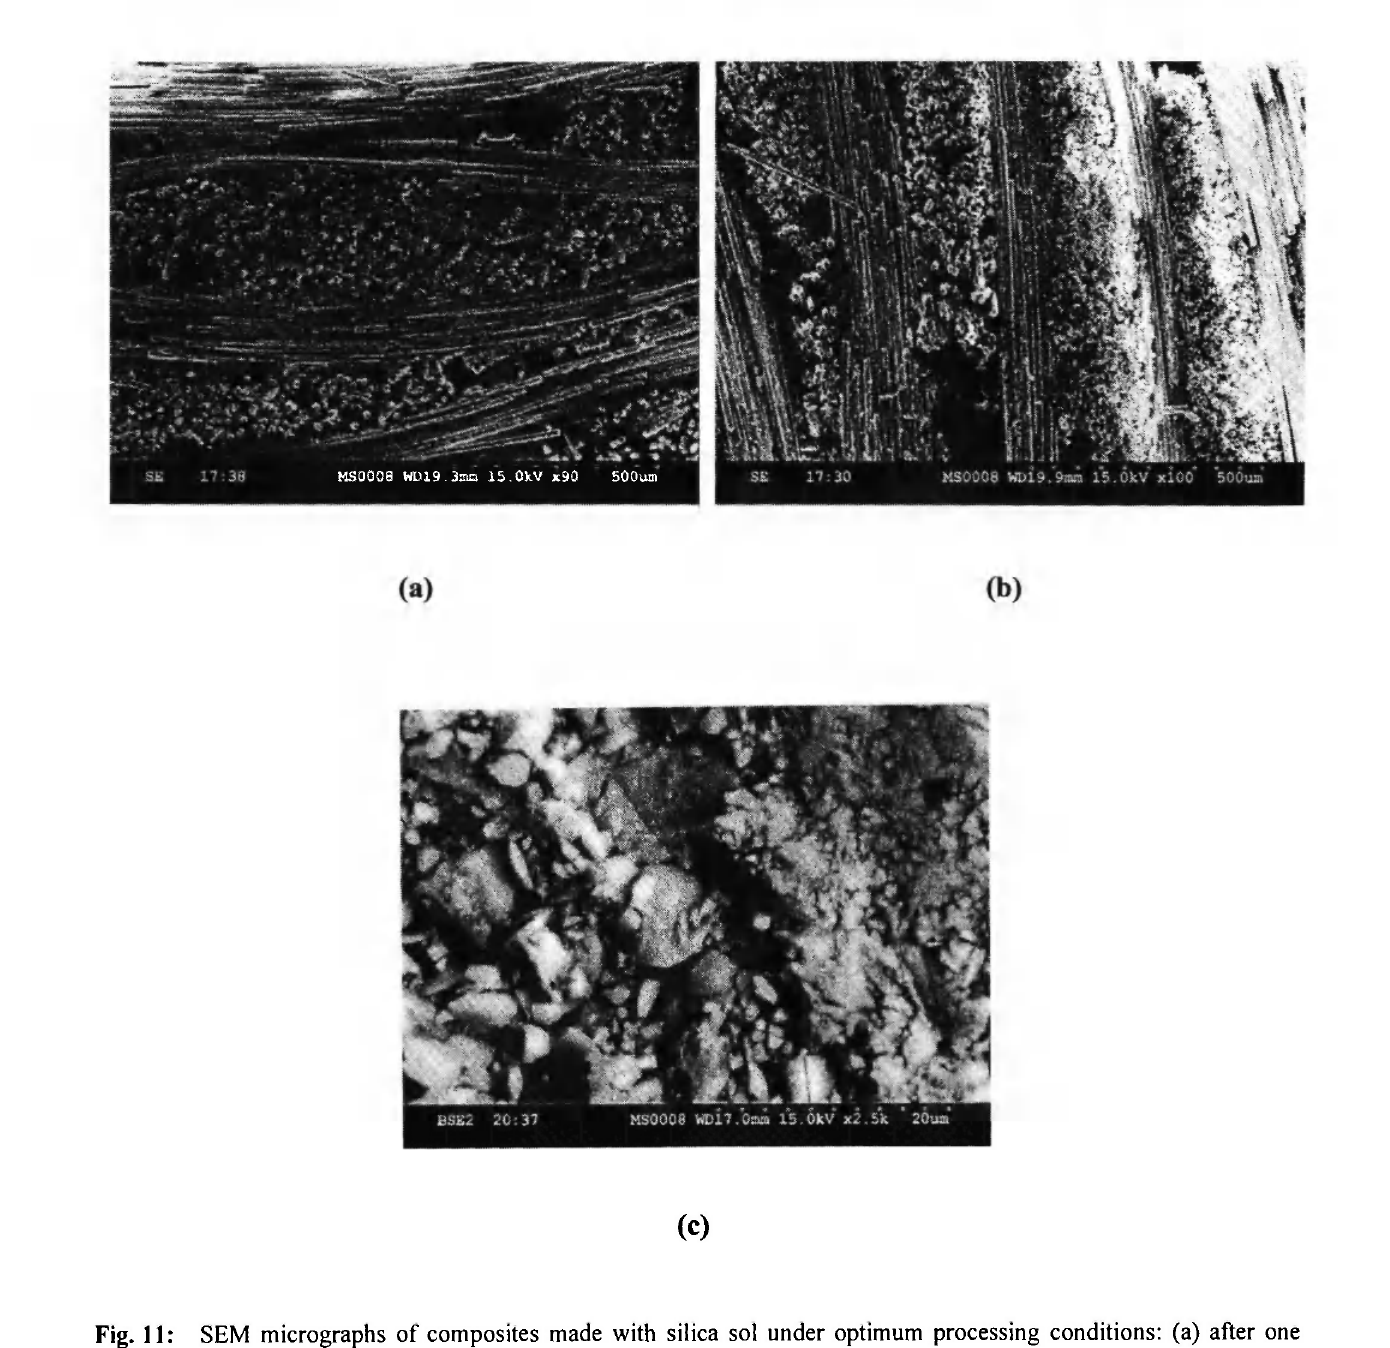
Fig. 11: SEM micrographs of composites made with silica sol under optimum processing conditions: (a) after one infiltration, (b) and (c) densified